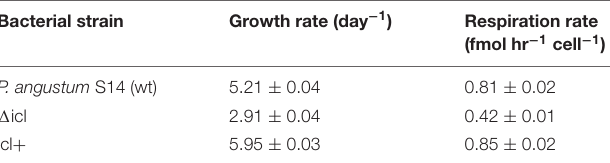
TABLE 1 | Growth and respiration rates obtained from (cid:49) O 2 measurements derived from eight replicates of P. angustum S14 (wt), (cid:49) icl and the complement icl + when grown in Fe-replete conditions containing 100 µ M